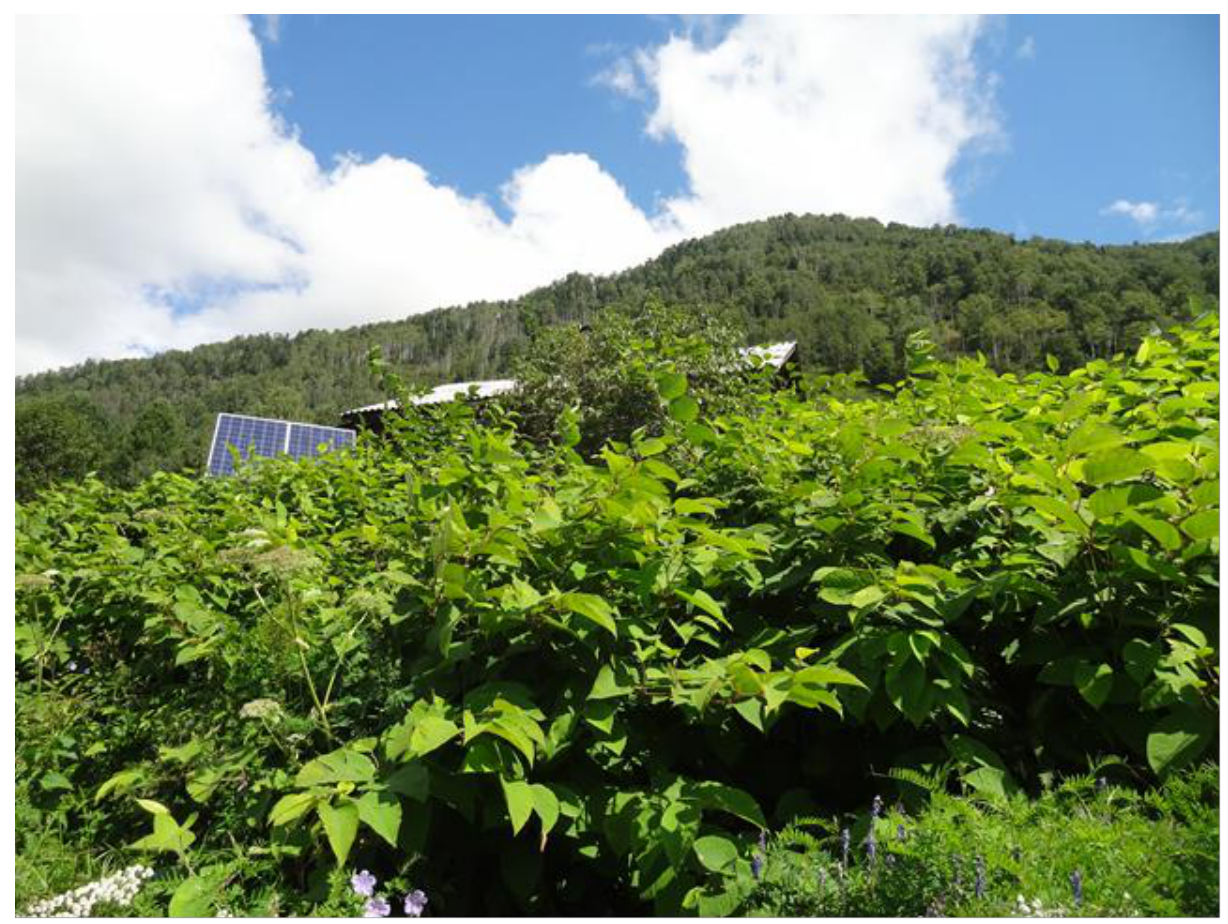
Fig. 5. Reynoutria sachalinensis near the Karatash ranger station in the Altaiskiy Reserve. Oppositely, the northern part of the Katunskiy Reserve is undergoing recreation pressure. In its protection zone there is a tourist base situated near the northern end of Lake Nizhnee Mul'tinskoe, as well as a ranger station and a tourist camp located near the southern end of Lake Srednee Mul'tinskoe. From there visitors take one day hiking routes to the core zone of the reserve, to Lakes Verkhnee Mul'tinskoe and Poperechnoe. From 1500 to 2000 people walk along these ecology trails per year. In spite of such rather substantial recreation pressure, only two naturalized potentially alien speсies were registered on the territories of the ranger station, tourist base and camp. These are Lepidotheca suaveolens and Potentilla norvegica which are not seldom on degraded low grass meadows and in weed plant communities. It worth to note that Potentilla norvegica was observed as in the lower part of the buffer zone near car parking (1677 m a.s.l) as well as rather high in the core zone in tundra community (2120 m a.s.l.), on the way of tourists which are going to the mountain pass. And if in the first case plants were 20 cm tall, in the second case it was one plant 2 cm tall. This suggest that the obstacle of spreading of this species in the core zone of the reserve is not the absence of dispersal agents, but severe conditions in high